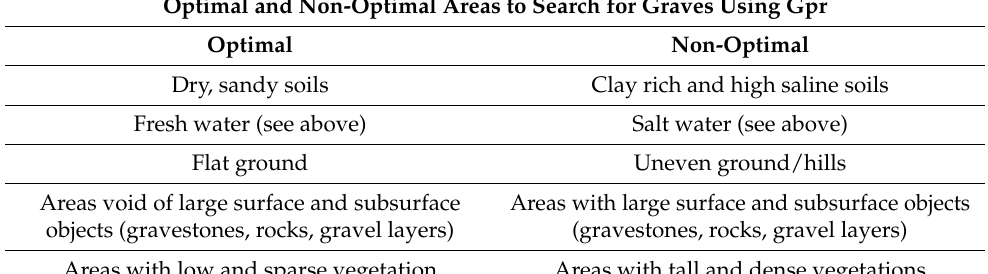
Areas with low and sparse vegetation Areas with tall and dense